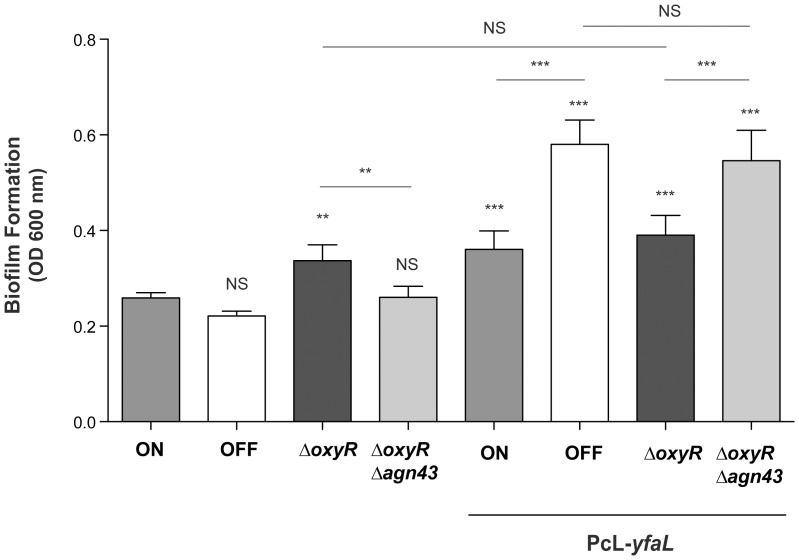
Ag43 interferes with YfaL-mediated biofilm formation.Biofilms were formed in 96-well micro-titer plates for 24 h; biofilm production was quantified by crystal violet staining as described in materials and methods. A TG agn43-lacZ background was used to monitor the ON or OFF state of colonies, ON: wild-type ON colony, OFF: wild-type OFF colony. PcL-yfaL strains constitutively expressing yfaL: agn43 ON/OFF colonies, ΔoxyR: locked-ON strain, ΔoxyR Δagn43: Δagn43::lacZ locked-ON strain. Unless specified statistical analyses were performed using the WT (ON) strain as a reference: NS: not significant, **: p<0.001, ***: p<0.0001.